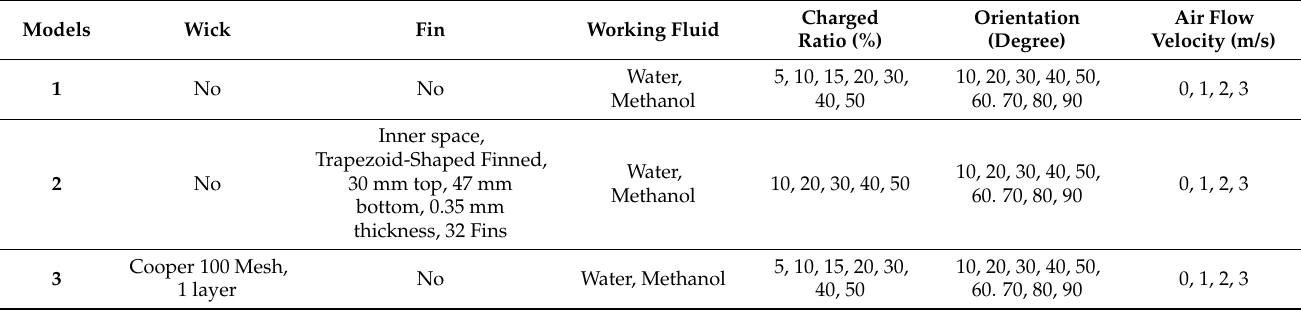
Table 1. Experimental Conditions.